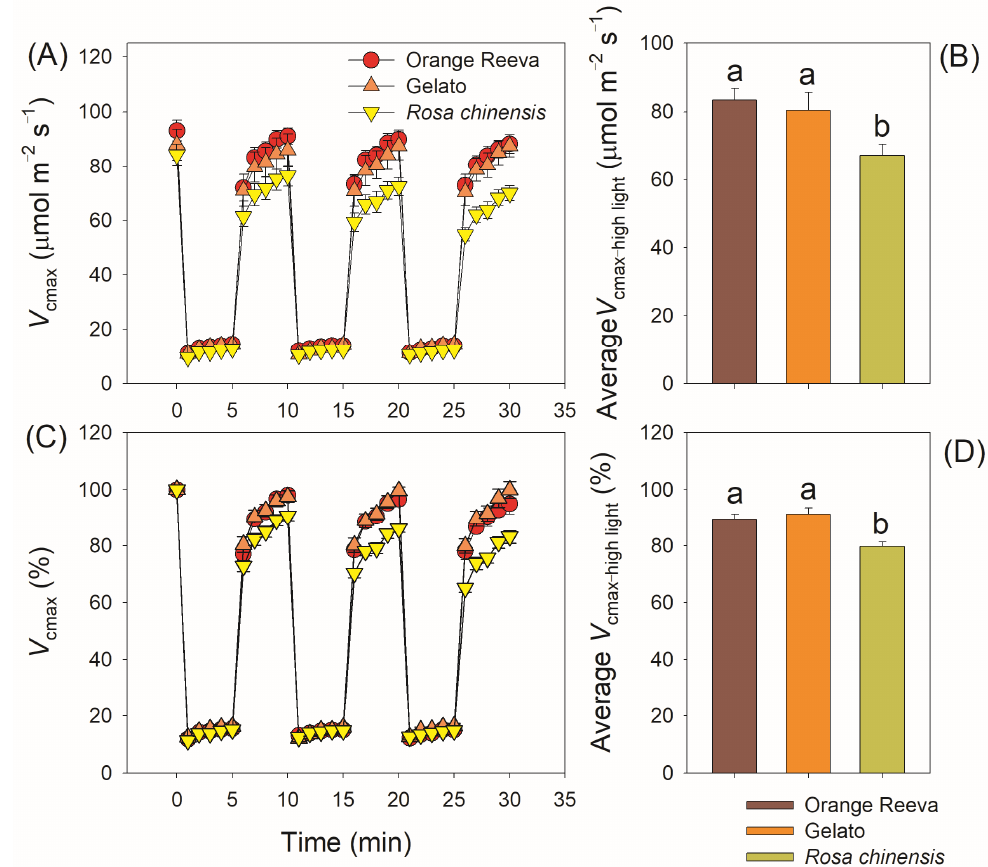
Figure 7. Dynamic changes ( A ), relative changes ( C ), and average values ( B , D ) of the maximum velocity of Rubisco carboxylation ( V cmax ) in two modern rose cultivars (Orange Reeva and Gelato) and the old Chinese rose plant Rosa chinensis . Adapted leaves were exposed to four repeated cycles of 100 and 1500 µ mol photons m − 2 s − 1 (every 5 min). Relative values were calculated as the percentage of the initial steady-state value. Data are means ± SE ( n = 5).